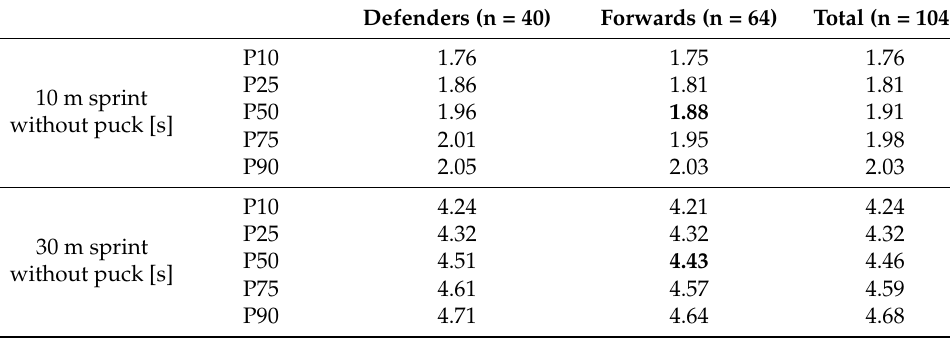
Table 2. Percentile data of linear forward sprint performance by playing position. Based on the 50th percentile, performance maxima marked in